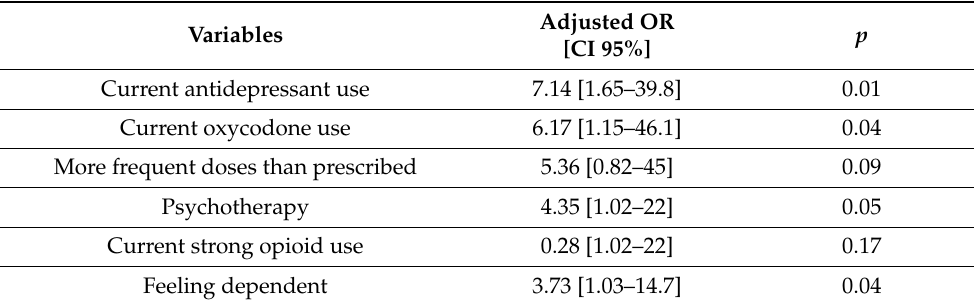
Table 5. Factors associated with moderate or severe p-OUD according to the multivariate logistic regression